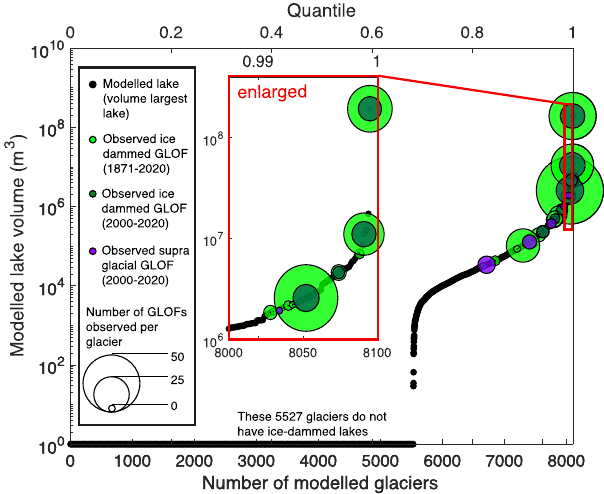
Fig. 6 Relation between observed GLOFs 13 and modelled ice-dammed lakes. The black dots (appearing like a line when close together) show the modelled maximum lake volume for each glacier (under SSP245). Glaciers are sorted by total lake volume, with the fi rst ca. 5600 glaciers not showing any ice-dammed lake formation at all. The green and purple spheres are observed GLOFs from ice-dammed and supraglacial lakes 13 , respectively. GLOFs from ice-dammed lakes before (light green) and after (dark green) 2000 are distinguished (2000 marks the start of our simulations, i.e., the acquisition year of the digital elevation model 50 , see Methods), and the size of the spheres depicts the number of GLOFs observed per glacier. Note that most GLOFs overlap with large modelled